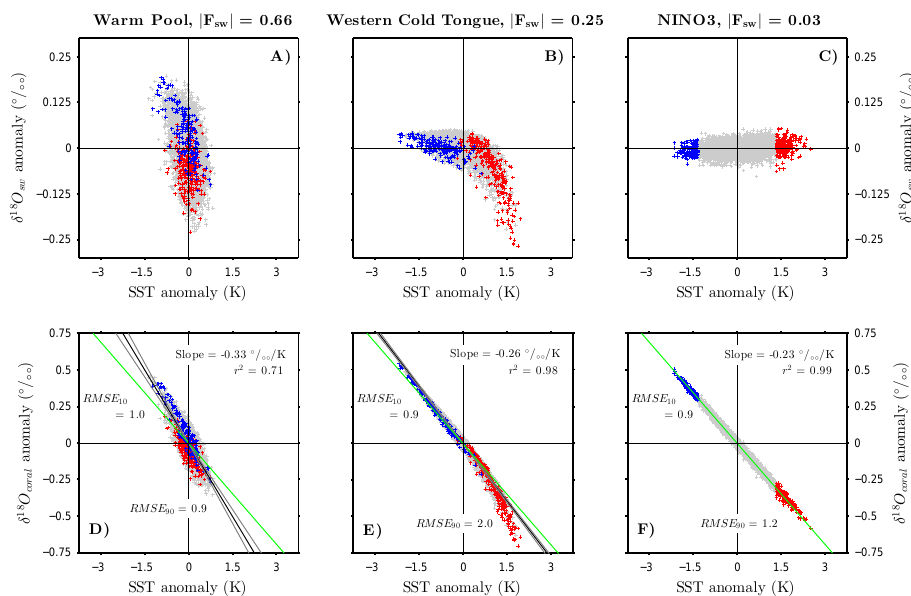
Fig. 3. Scatter plots of the relationships between the inter-annual monthly anomalies of δ 18 O sw and SST (upper panels) and δ 18 O coral and SST (lower panels), as calculated for the spatial averaged indices over the Warm Pool, Western Cold Tongue and NINO3 boxes. The locations of these regions are shown on Fig. 2. The data points are color-coded according to the corresponding NINO3 SST anomalies, with the upper ten percentiles shown in red (eastern Pacific El-Ni˜no type conditions) and the lower ten percentiles in blue (eastern Pacific La-Ni˜na type conditions). The black regression lines on the lower plots show the best-fit linear regressions through the data, with the slope and r 2 values annotated on the plots. The RMSE 10 and RMSE 90 metric values associated with the best-fit linear slopes are also annotated on these plots. The grey lines show the two-tailed 95 % confidence bounds on the best-fit regression slopes, based on the assumption of an assumed decorrelation time of 4 yr. The green lines show the imposed R SST − coral slope of − 0.23 ‰ K − 1 .